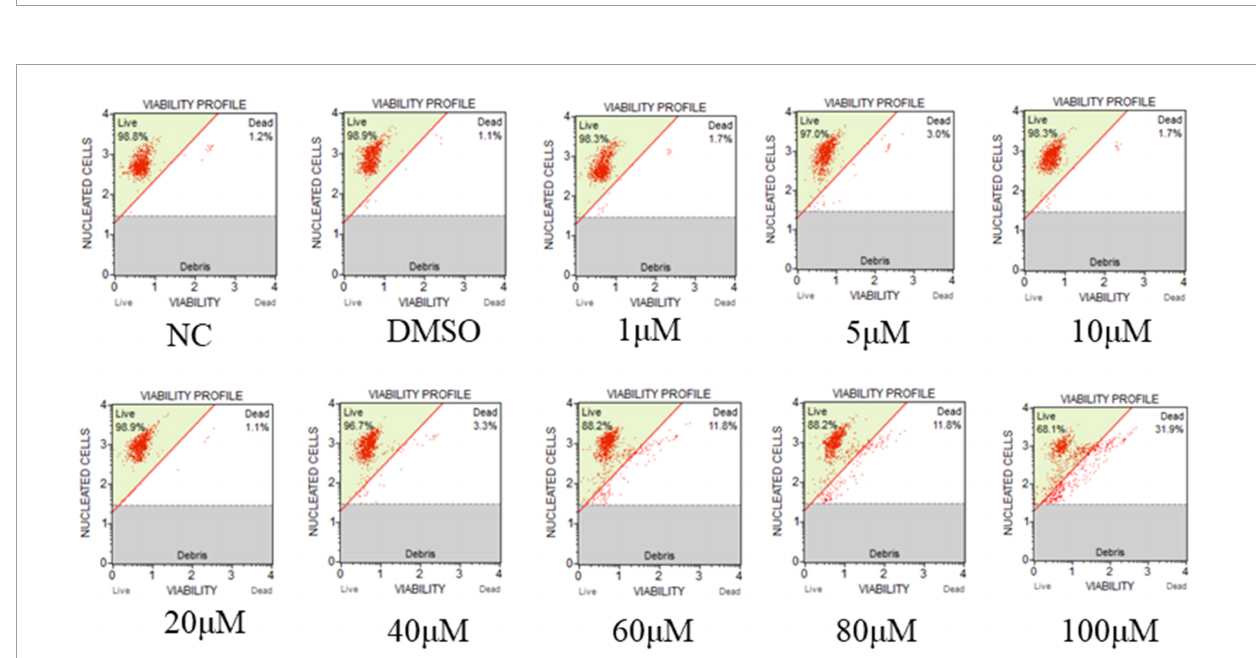
FIGURE8 Effect of hydroxyurea on GICF cell. The effects of different dosages of hydroxyurea (0, 1, 5, 10, 20, 40, 60, 80, and 100 µ M) on GICF cells were observed by microscope, and the activity of GICF cells was determined by Guava R (cid:13) Muse R (cid:13) cell analyzer.